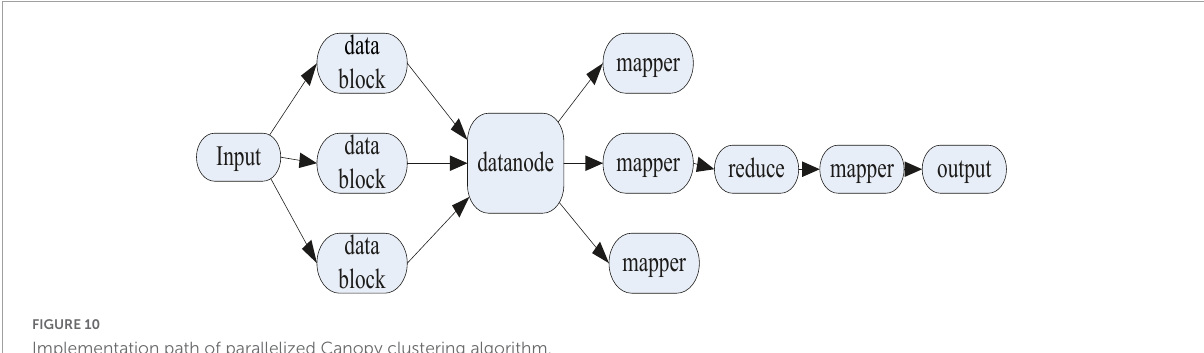
FIGURE10 Implementation path of parallelized Canopy clustering algorithm.